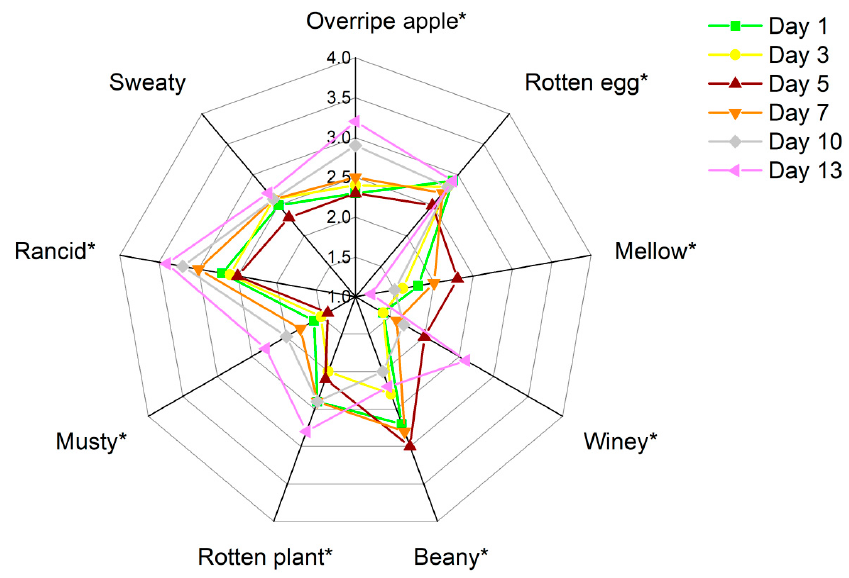
Figure 1. Sensory aroma profiles of the stinky tofu samples in different storage periods. ‘*’ indicates the significance ( p < 0.05) according to ANOVA and Duncan’s multiple comparison tests.